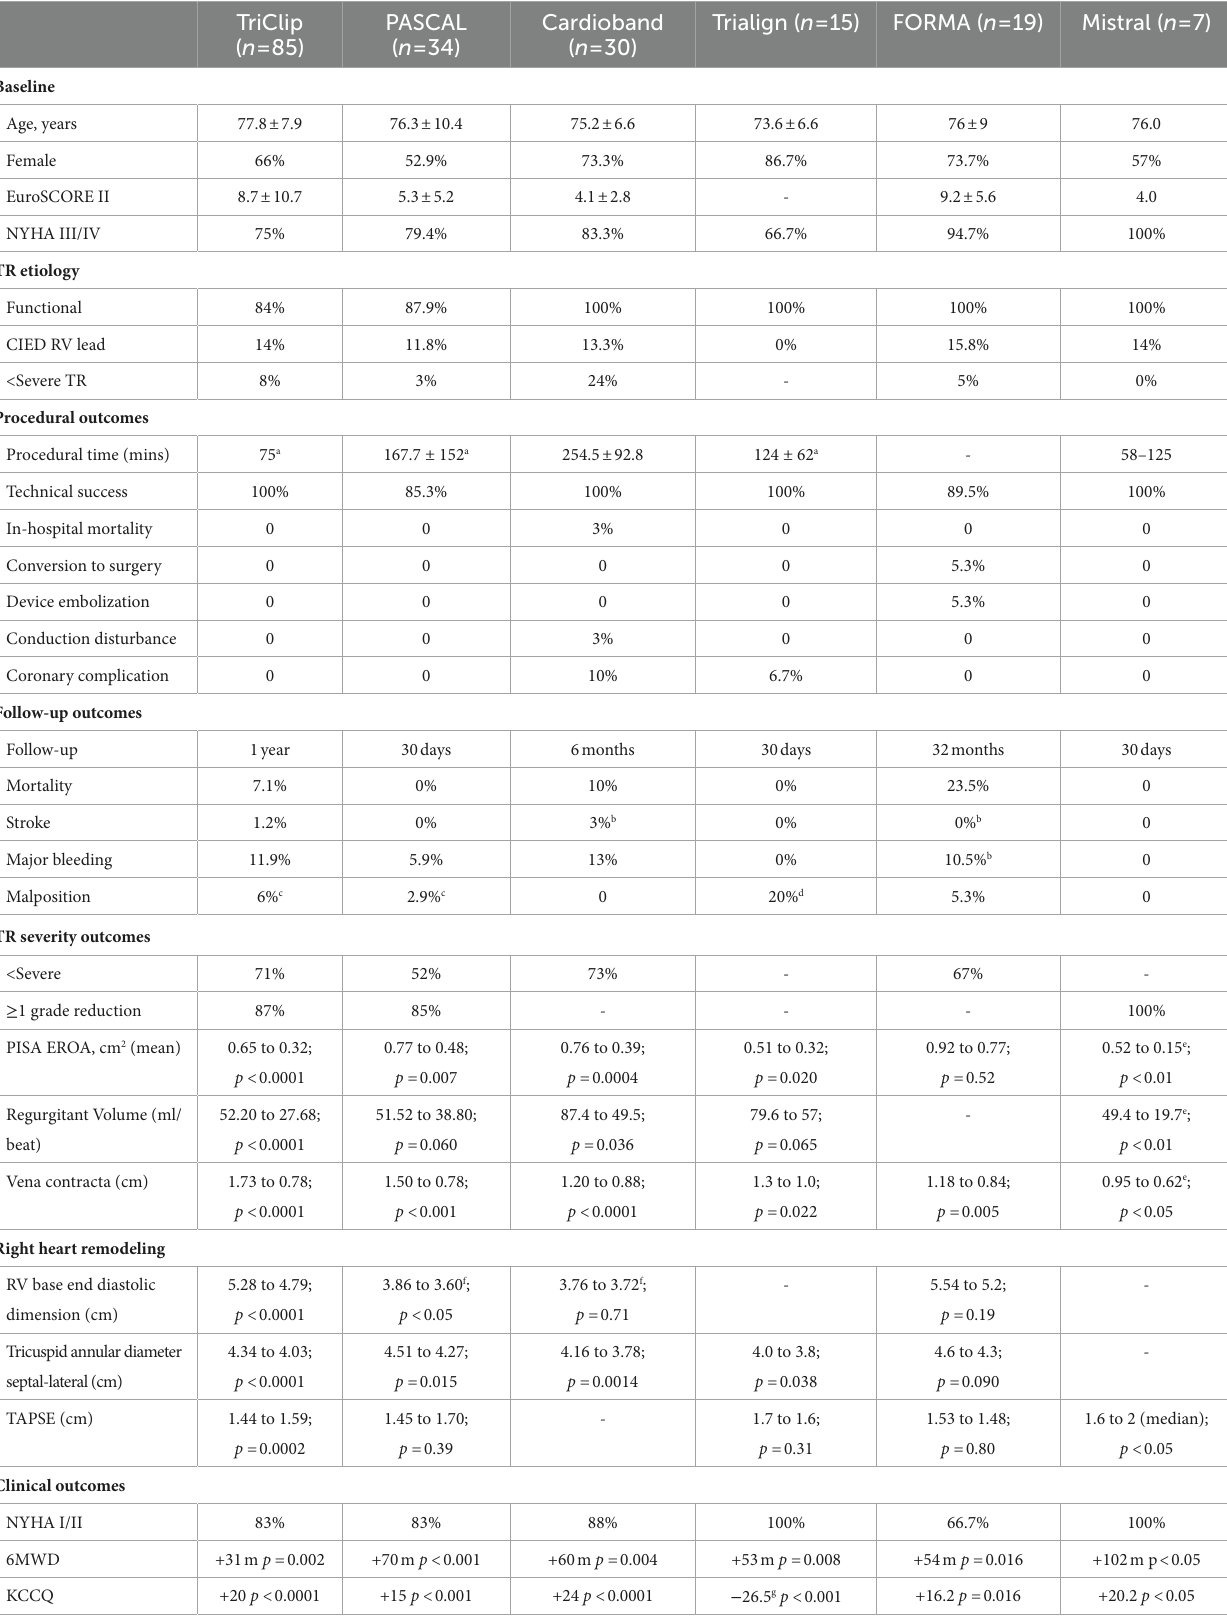
TABLE 2 Summary of available clinical data in transcatheter tricuspid